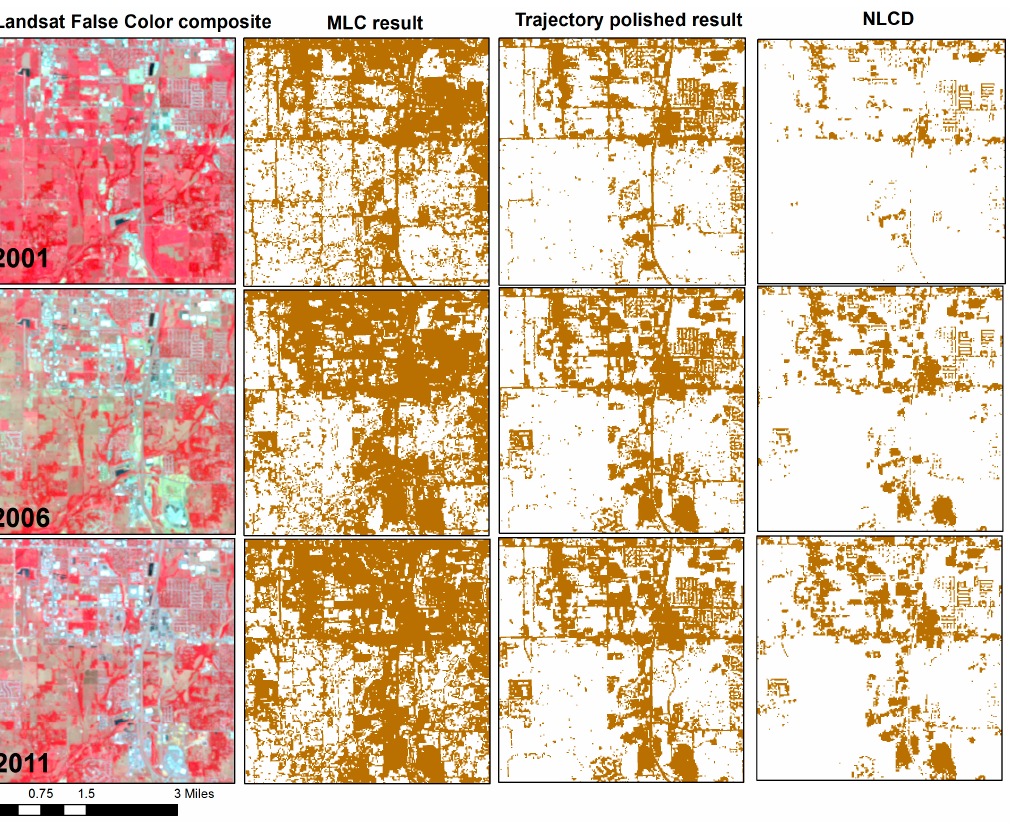
Figure 6. An example in south Bentonville showing the comparison of maximum likelihood classification results, trajectory polished results, and NLCD maps in years 2001, 2006, and 2011.